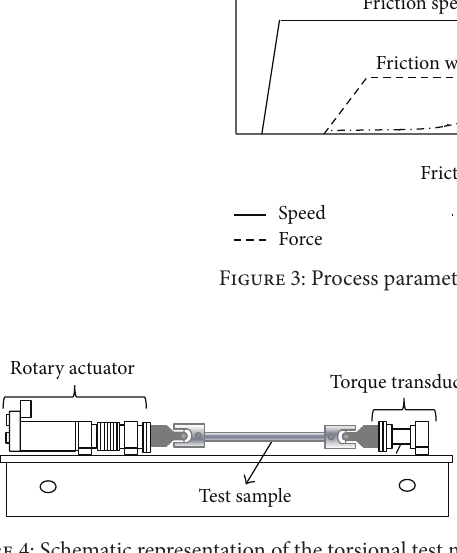
Figure 4: Schematic representation of the torsional test machine.